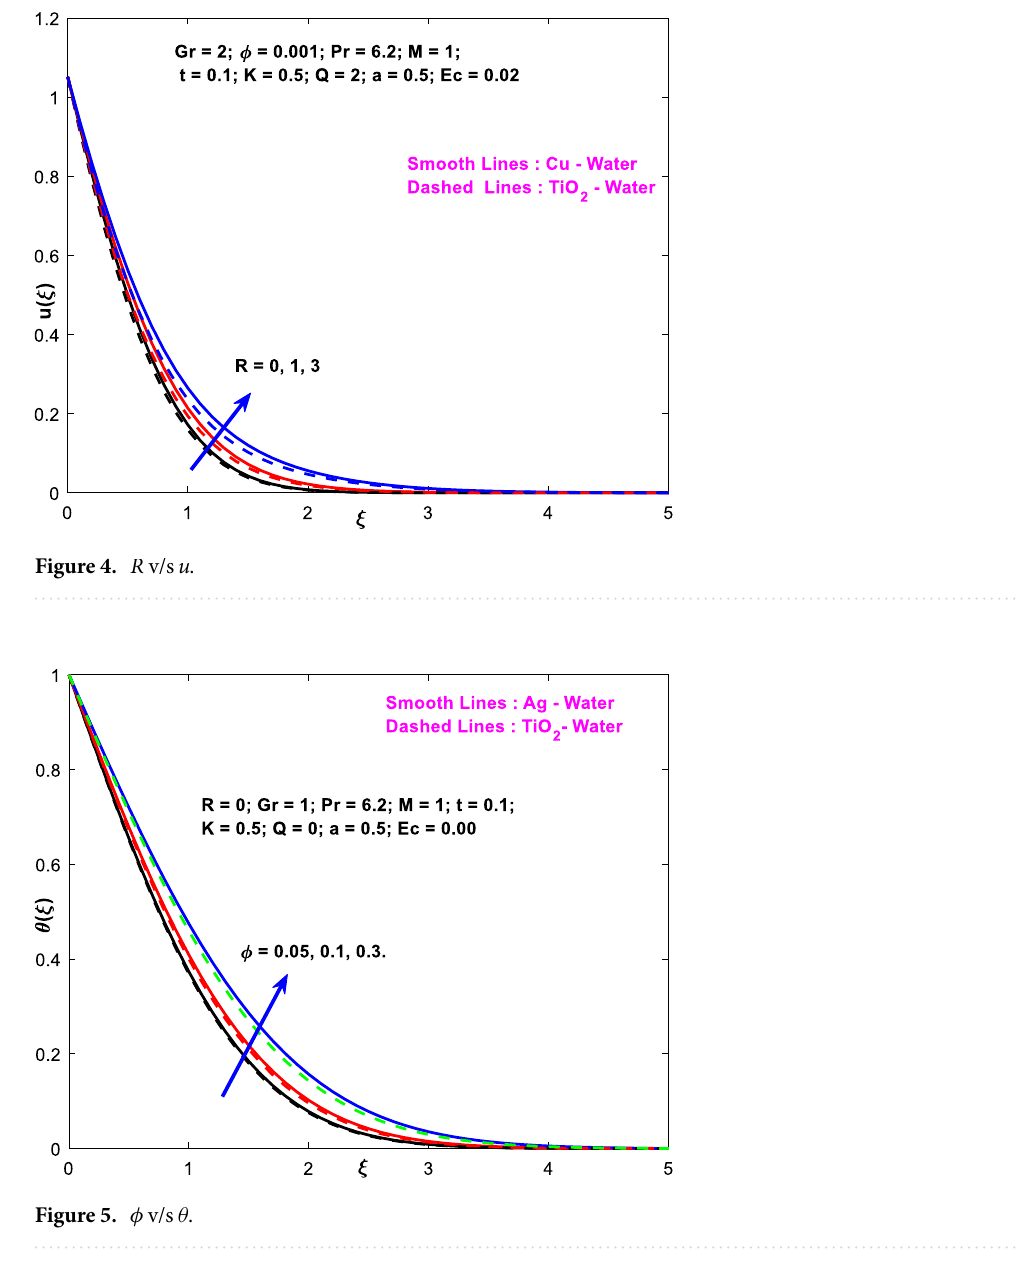
Figure 5. φ v/s θ